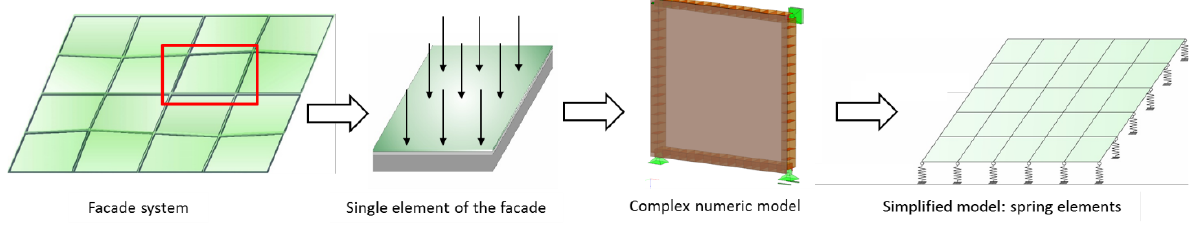
Fig. 12 Numerical evaluation scheme.